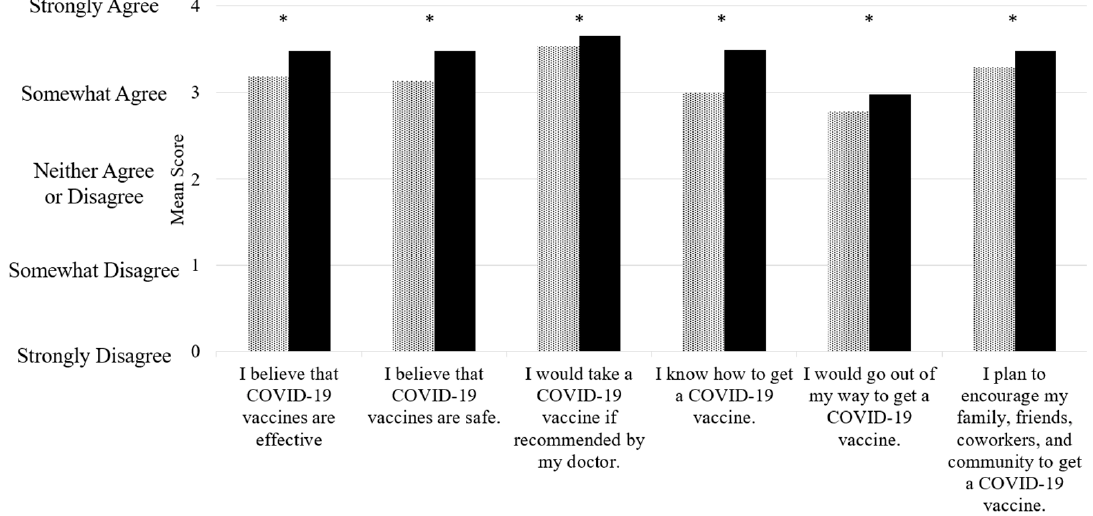
Figure 4. Changes in beliefs and perspectives on vaccines against COVID-19 before and after a webinar. Dotted bars represent data collected before the webinar. Black bars represent data col-